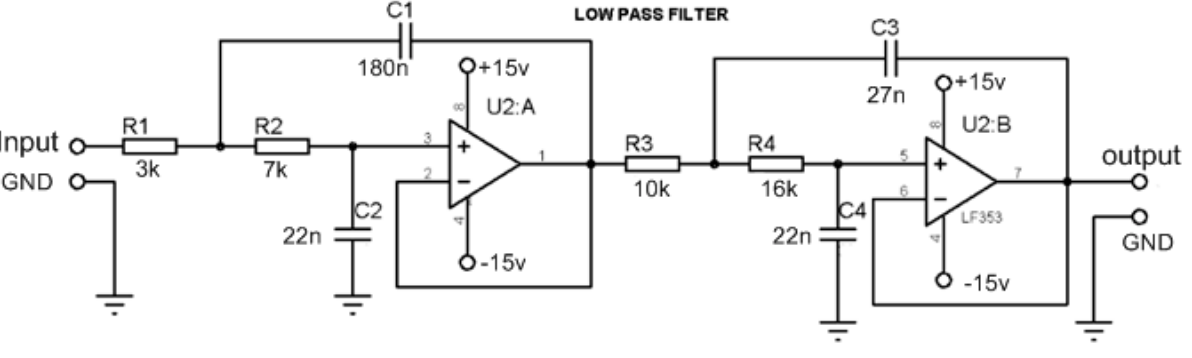
Figure 3. Low-pass, filter fourth-order circuit.